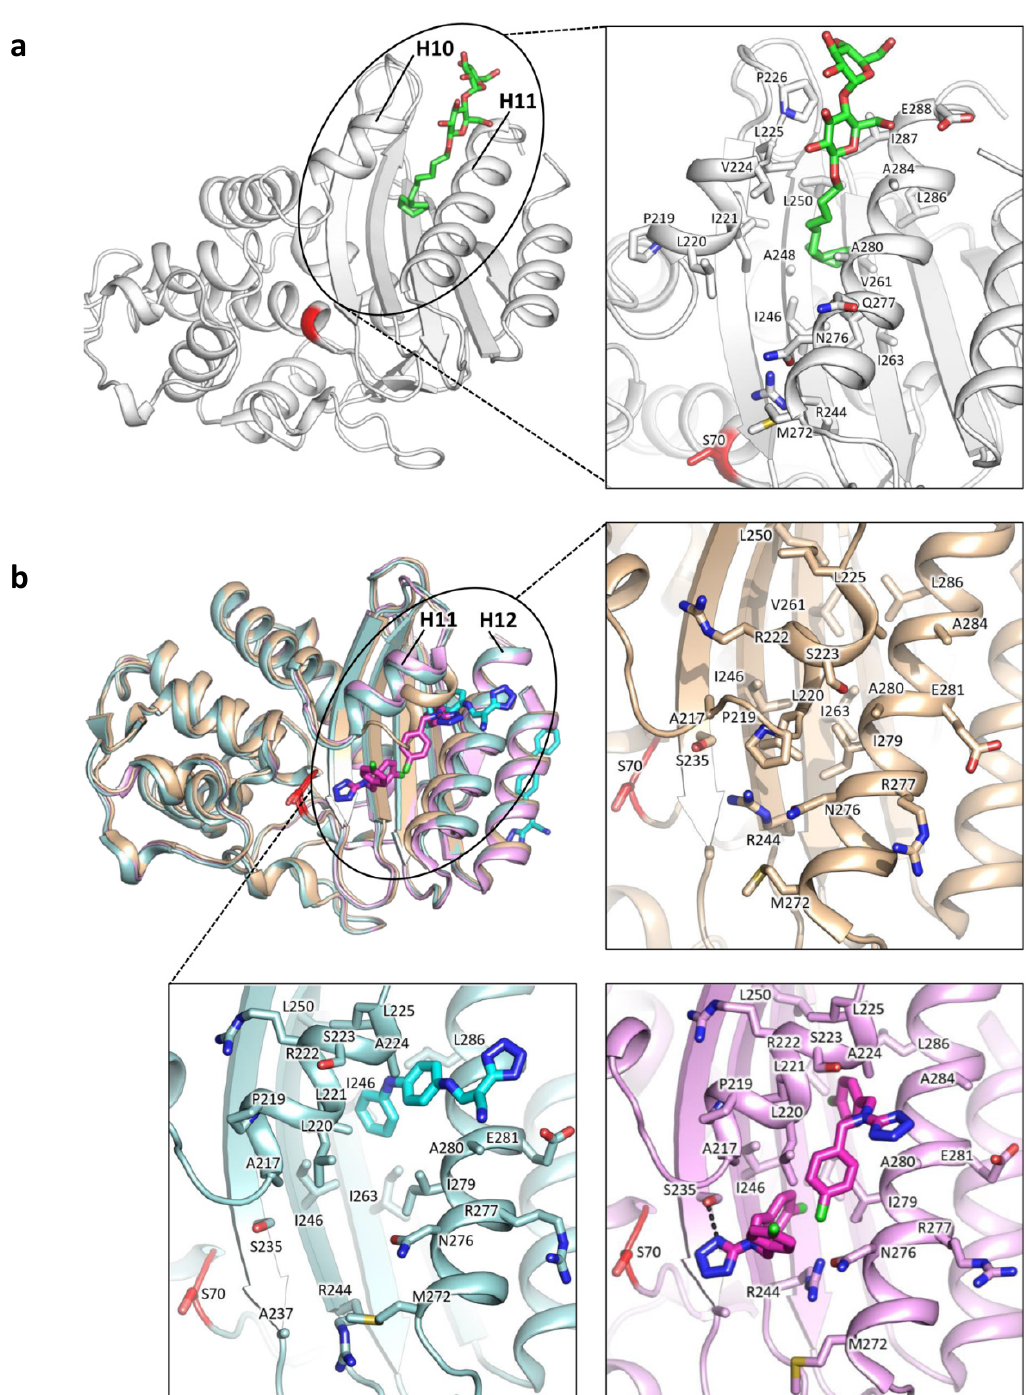
Figure 5. Allosteric e ff ectors in site A1 of BLs SHV-1 and TEM-1. ( a ) SHV-1 X-ray structure (PDB IDs: 1shv) with Cymal-6 (green) bound to the cryptic site A1. ( b ) Superposition among two holo and an apo TEM-1 X-ray structures (PDB IDs: 1pzp (teal), 1pzo (pink), and 1yt4 (light orange), respectively). Proteins are represented in cartoon, while ligands are depicted in bright-colored sticks (Cymal-6, green; FTA, cyan; CBT, magenta). Catalytic Ser70 is highlighted in red as a reference for the position of the active site, while the cryptic site A1 area is approximated by an oval shape. For each X-ray structure in both ( a , b ), a close-up of ligand binding modes in the cryptic site is reported, with residues labelled with one letter code and depicted in capped sticks. For clarity, water molecules have been omitted. Residues are numbered according to the standard numbering scheme [28].